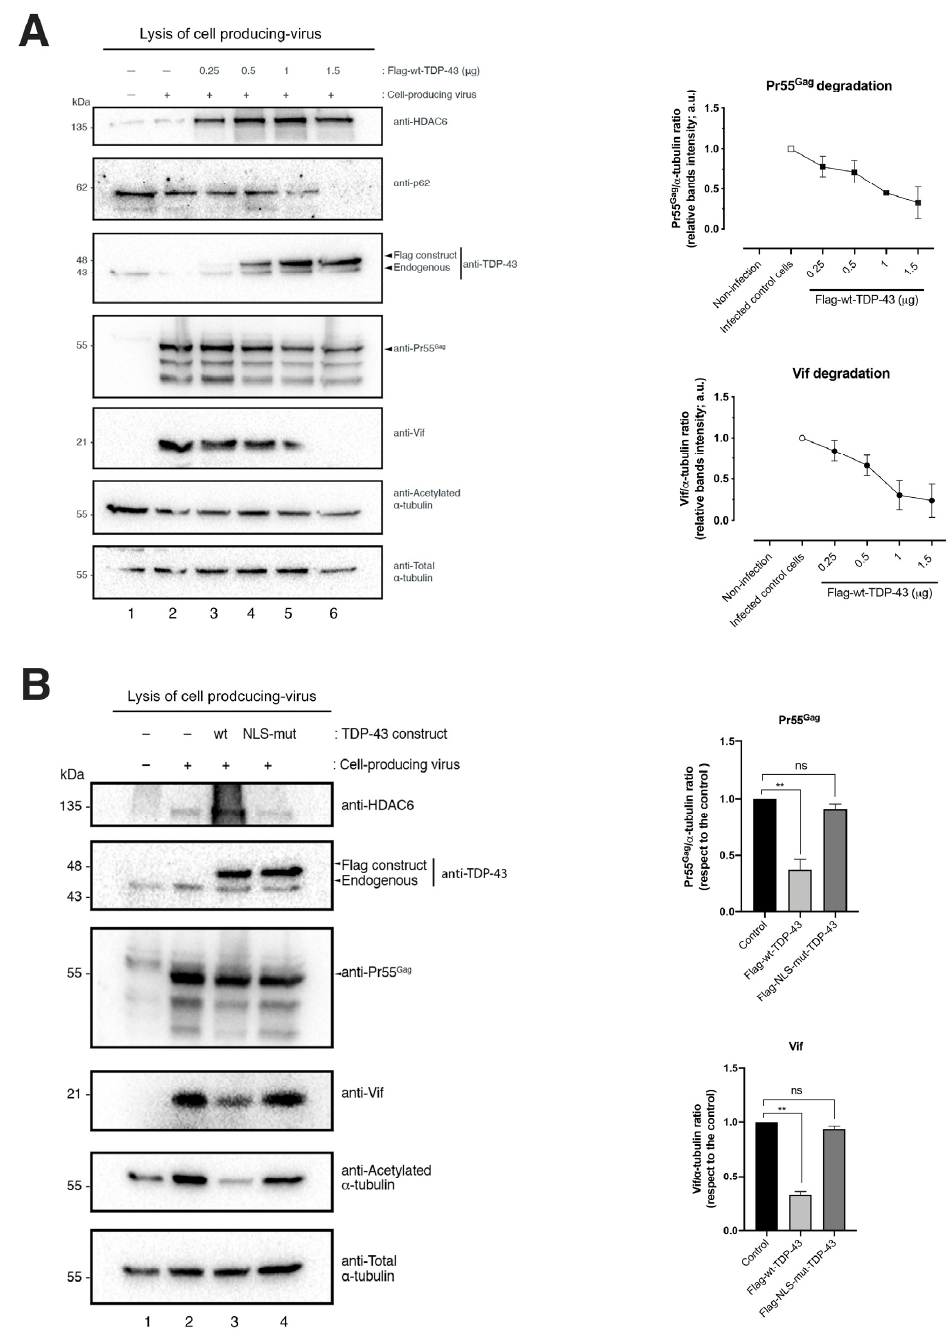
Figure 2. TDP-43 overexpression stabilizes HDAC6 and degrades HIV-1 Pr55 Gag and Vif viral proteins. ( A ) Biochemical western blot analysis of Flag-wt-TDP-43 overexpression in cell lysates of virus-producing HEK-293T cells (Env-BaL + viral backbone pNL4-3.luc.E-R- (see Materials and Methods section)) transduced with the Flag-wt-TDP-43 construct in an increasing plasmid dose (0, 0.25, 0.50, 1, and 1.5 µg). The level of expression of the Pr55 Gag and Vif viral proteins were also analyzed together with stabilized HDAC6 and its acetylated α -tubulin substrate. Total α -tubulin for protein load control is shown under each experimental condition. A representative experiment of three is